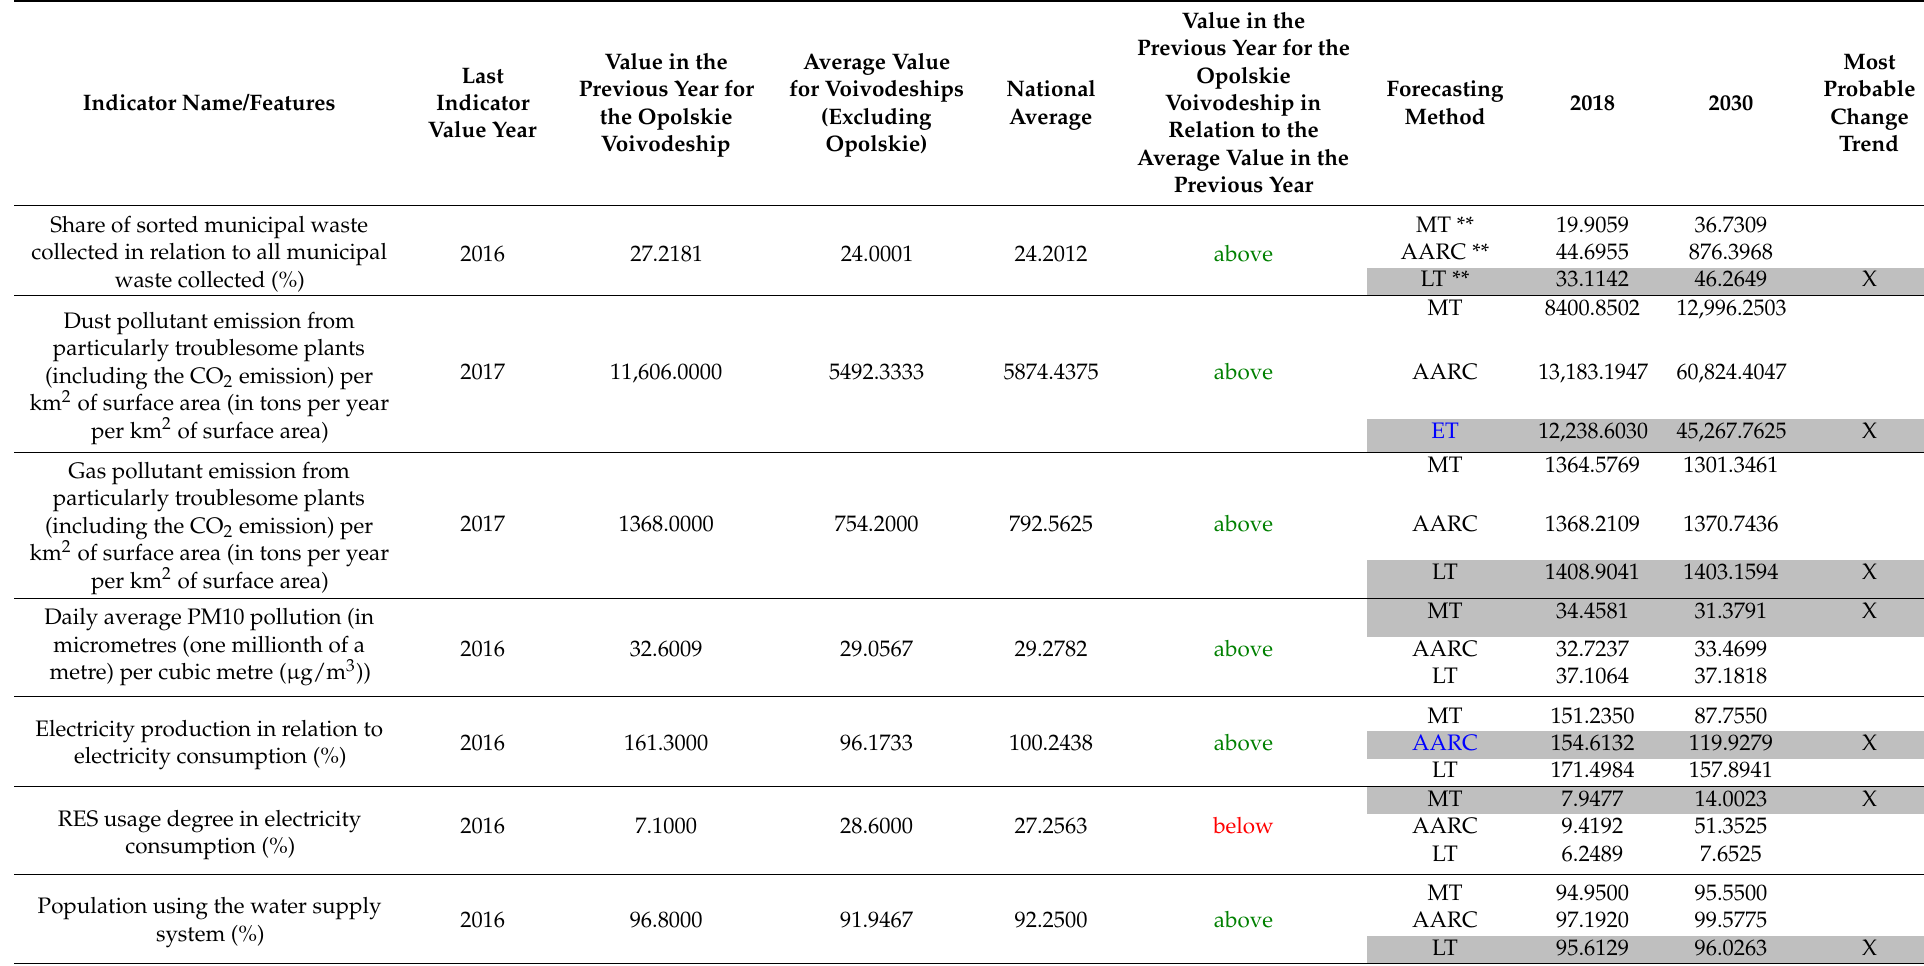
Table 4. A summary of the estimated indicator value